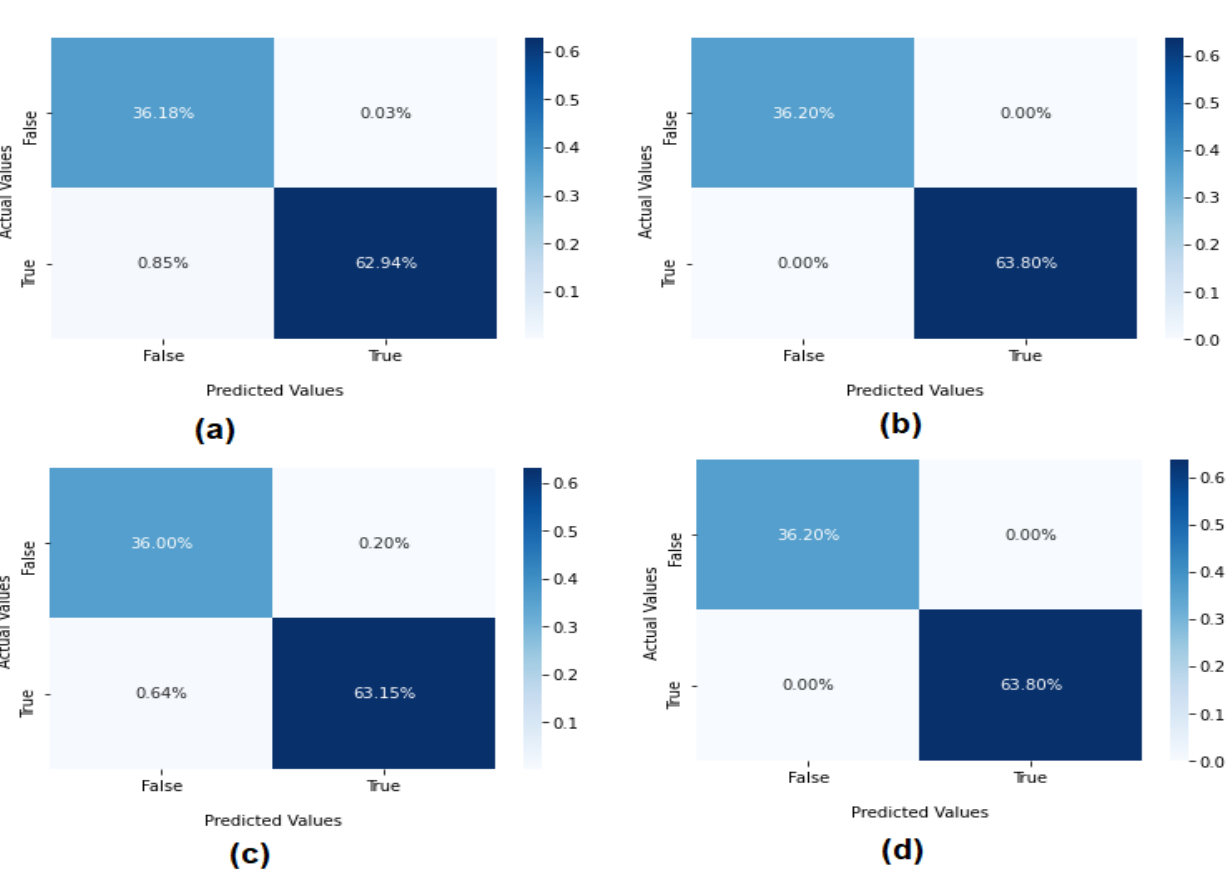
Table 7. Results of the DL CNN-LSTM model for detecting ICS attacks using binary classification .